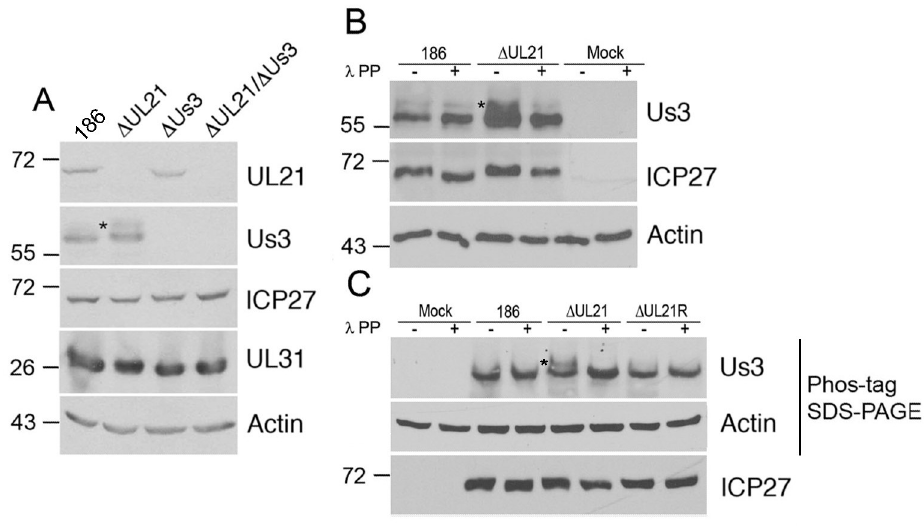
Fig 1. HSV-2 pUs3 kinase is phosphorylated in Δ UL21 infected cells. (A) Whole cell lysates prepared at 18 hours post infection from Vero cells infected at an MOI of 3 with the viruses indicated at the top of the panels or from mock infected cells were electrophoresed through polyacrylamide gels and proteins transferred to PVDF membranes. Membranes were probed with antisera indicated on the right side of each panel. Molecular weight markers in kDa are indicated on the left side of the panels. Asterisk indicates a slower migrating species of pUs3 that was prominent in cells infected with Δ UL21. (B) Whole cell lysates prepared at 18 hours post infection from Vero cells infected at an MOI of 3 with the viruses indicated at the top of the panels or from mock infected cells were either treated with λ protein phosphatase ( λ PP) or untreated, then electrophoresed through polyacrylamide gels and proteins transferred to PVDF membranes. Membranes were probed with antisera indicated on the right side of each panel. Molecular weight markers in kDa are indicated on the left side of the panels. Asterisk indicates a slower migrating species of pUs3 that was prominent in cells infected with Δ UL21 virus. (C) Whole cell lysates prepared at 18 hours post infection from Vero cells infected at an MOI of 3 with the viruses indicated at the top of the panels or from mock infected cells were either treated with λ protein phosphatase ( λ PP) or untreated, then electrophoresed through a regular (lower panel) or phos- tag SDS polyacrylamide gels and proteins transferred to PVDF membranes. Membranes were probed with antisera indicated on the right side of each panel. Molecular weight markers in kDa are indicated on the left side of the panels. Asterisk indicates a slower migrating species of pUs3 that was prominent in cells infected with Δ UL21